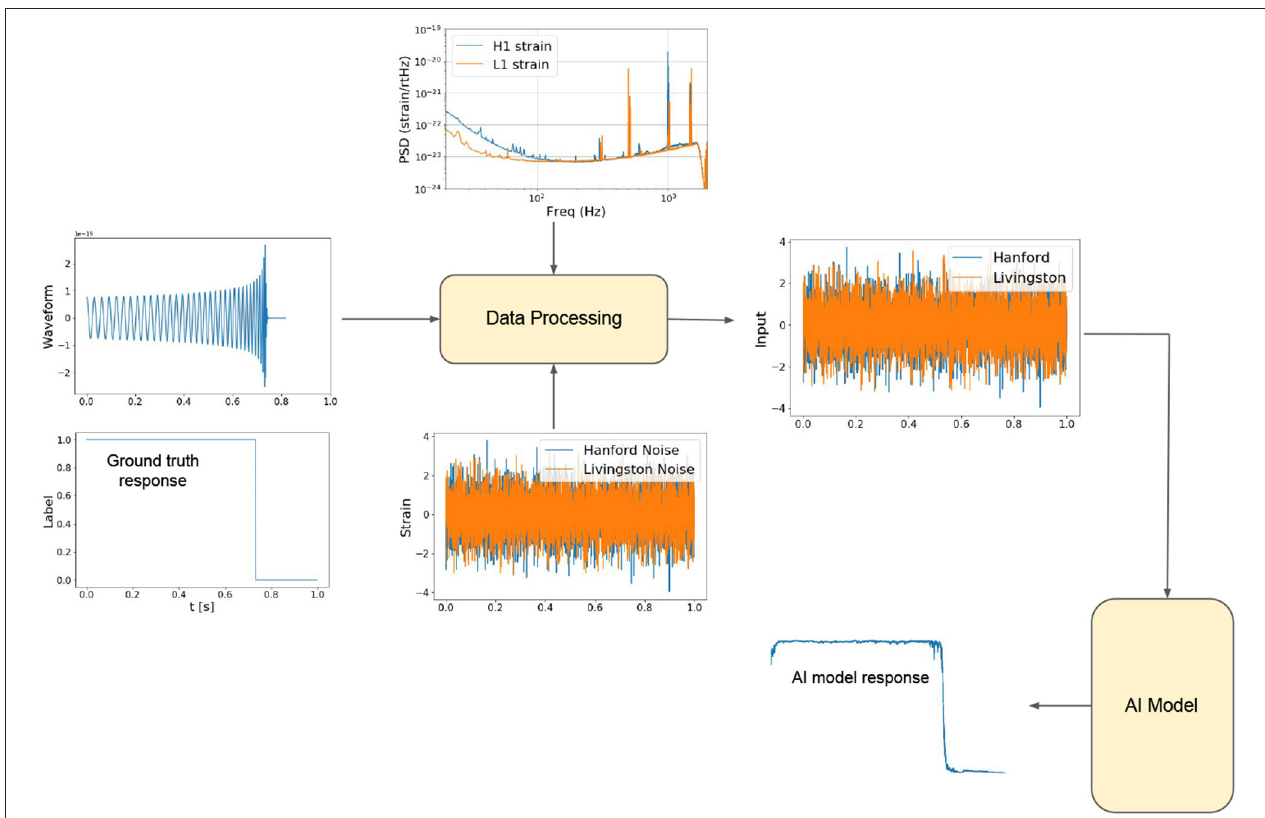
FIGURE 2 | Model creation. Methodology used for data curation, model training, and